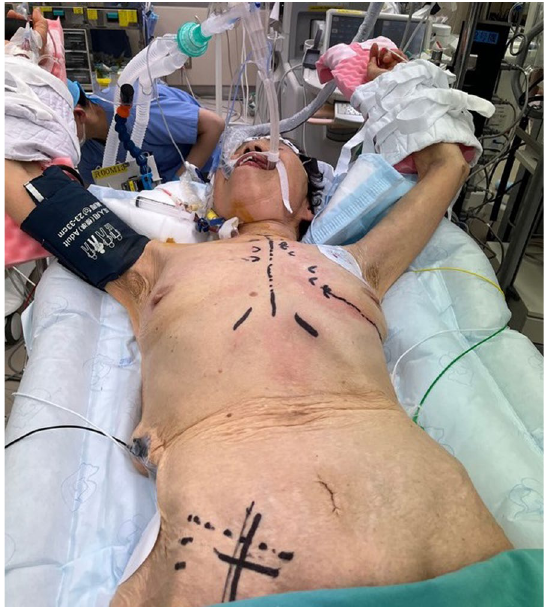
Fig. 2 Operative position. The patient was placed in the supine position with both arms